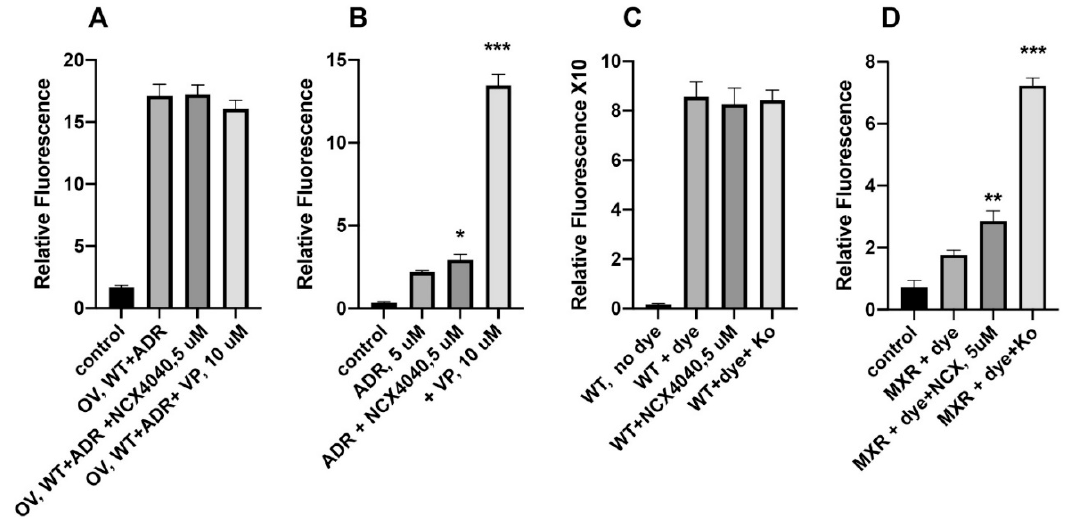
Figure 8. Effect of NCX4040 (5 µM) on accumulations of ADR in OVCAR WT ( A ) and NCI/ADR-RES cells ( B ) in the presence or absence of 10 µM verapamil. Effects of NCX4040 (5 µM) on accumulations of Hoechst 33342 in MCF-7 WT( C ) and MCF-7/MXR cells ( D ) in the presence or absence of Ko143 (500 mM). The relative cellular fluorescence values in the presence of Ko143 × 10. *, ** and *** p values <0.05, <0.005 and <0.001, respectively compared to drug (dye) alone.